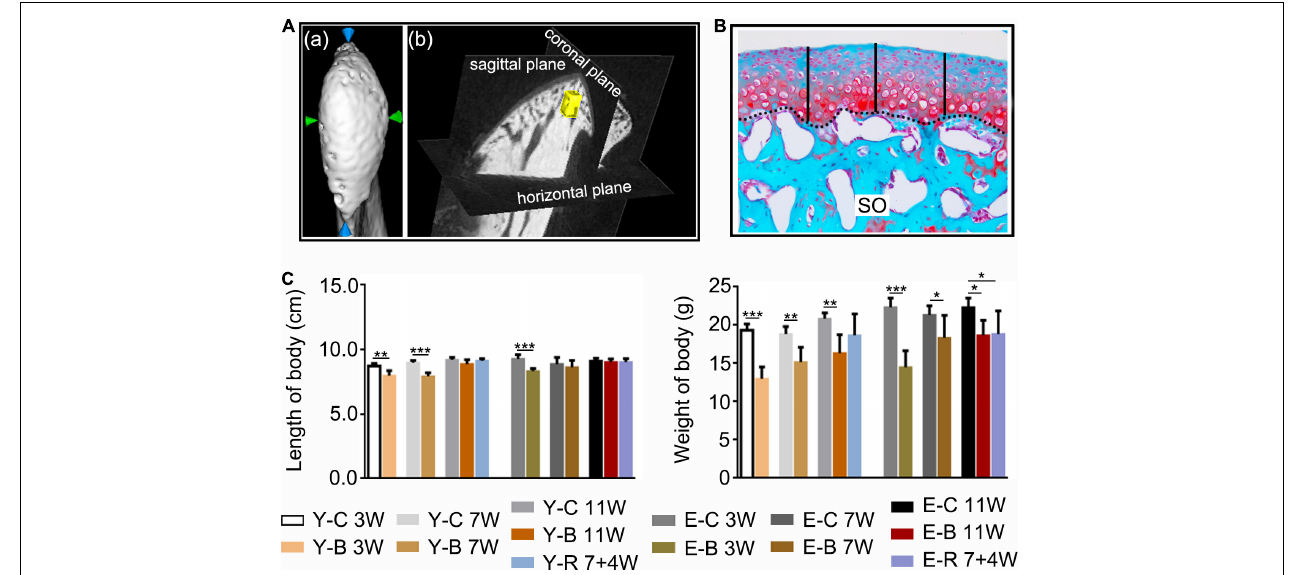
FIGURE 2 | (A) The measuring methods for condylar length and width (a), and for the measured regions of interest (ROI, 0.25 mm × 0.25 mm × 0.25 mm) (yellow block) of the subchondral trabecular bone (b) using the software provided by the micro-CT manufacturer. (B) The histomorphology measuring method of the cartilage thickness (black-dotted line for the osteochondral interface). Safranin O staining. Middle third of the sagittal sections were selected, three locations at the quintuple points were measured as indicated by the black vertical short lines. (C) Comparisons of body length and body weight between the indicated groups at the different time points. Data are presented as mean ± SD. Unpaired t -test was used for comparisons between the age-matched control and BAC groups. One-way ANOVA was used for comparisons among the age-matched control, BAC, and BAC removal groups. n = 6. * P < 0.05; ** P < 0.01 and *** P < 0.001 for the differences between all BAC and removal groups and the age-matched control groups. SO, safranin O; FC, full zone cartilage. For grouping and time points, please refer to Figure 1A